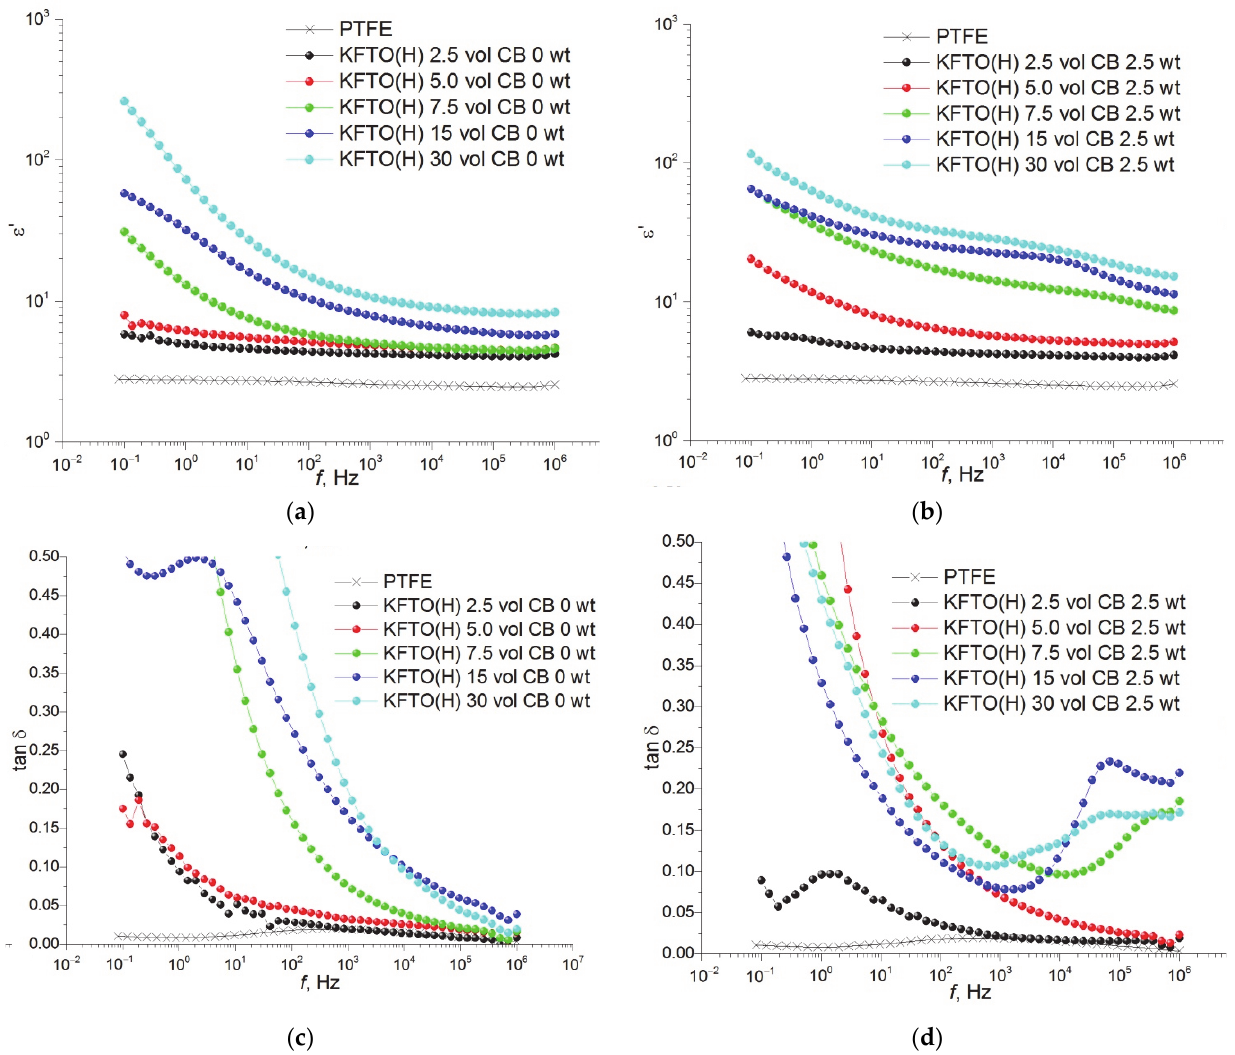
Figure 7. Dielectric properties of the frequency dependence of PTFE/KFTO(H) ( a , c ) and PTFE/KFTO(H)@CB ( b , d ) composites.